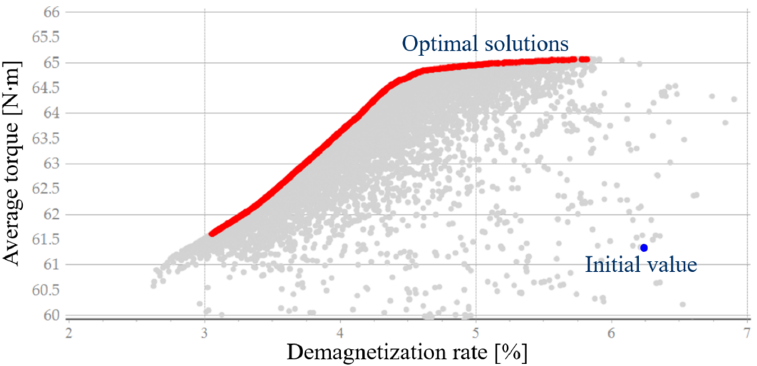
Figure 8. Pareto front of the multi-objective functions.